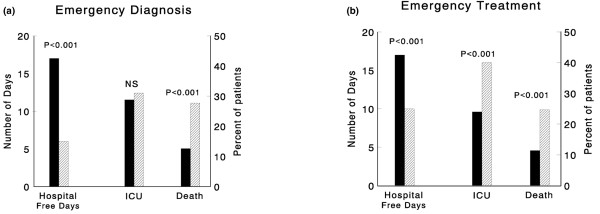
Effects of an appropriate medical care in the emergency department on prognosis. Effects of an appropriate (full bars) or inappropriate (hatched bars) diagnosis in the emergency department (a) or initial emergency treatment (b) on the number of hospital-free days within 1 month after admission (expressed as median), percentage of patients admitted to intensive care unit (ICU), or mortality. NS, not significant.